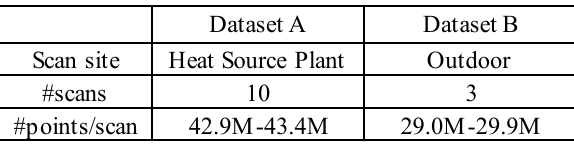
Table 1. Datasets used in the experiments